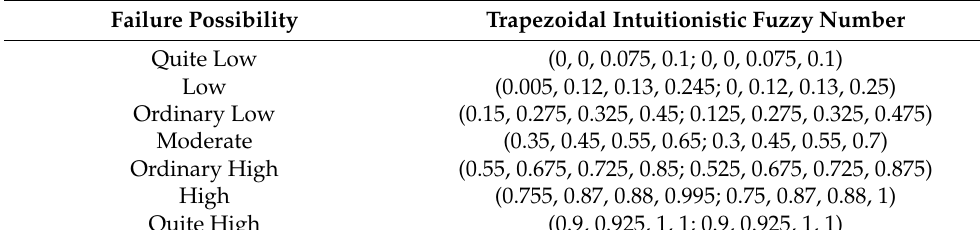
Table 6. Trapezoidal intuitionistic fuzzy number corresponding to failure possibility.